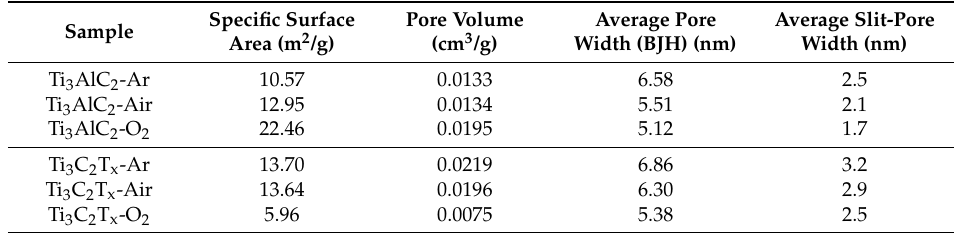
Table 1. Specific surface area, pore volume and pore diameters calculated for investigated MAX phases and derived